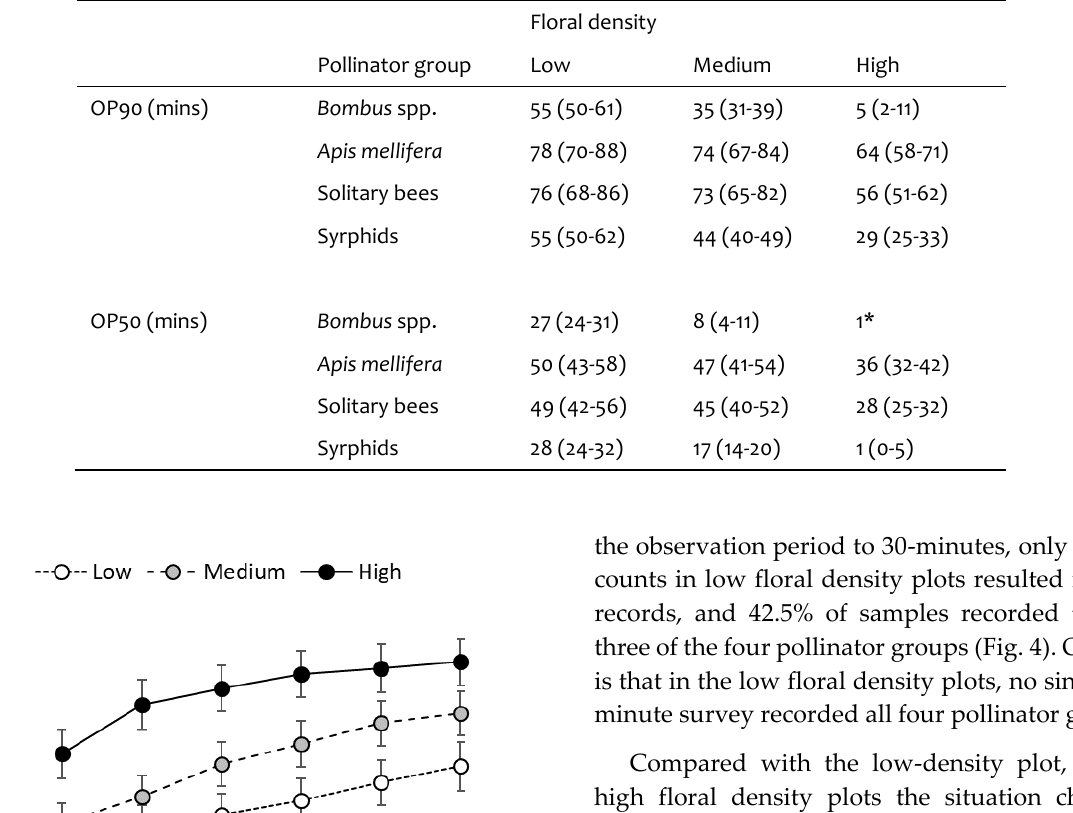
Table 3. Observation periods (OP) estimated to achieve 90% (OP90) and 50% (OP50) detection rates of four pollinator groups in an Irish meadow in 2 x 2 m quadrats assigned as having low, medium, and high density of floral units. *assigned a nominal value of 1 minute as calculated value was negative.